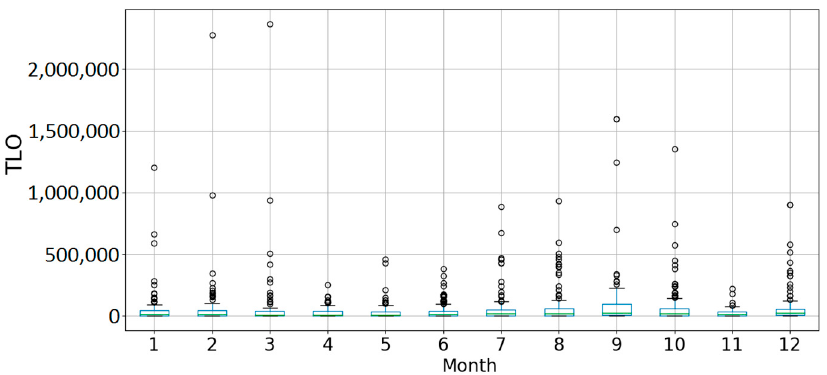
Figure 8. Monthly distribution of revenue loss (USD millions) in the overall U.S. due to power outages [29].